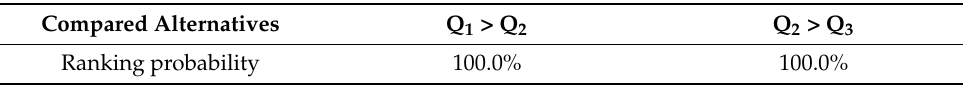
Table 5. Ranking probabilities of compared alternatives.